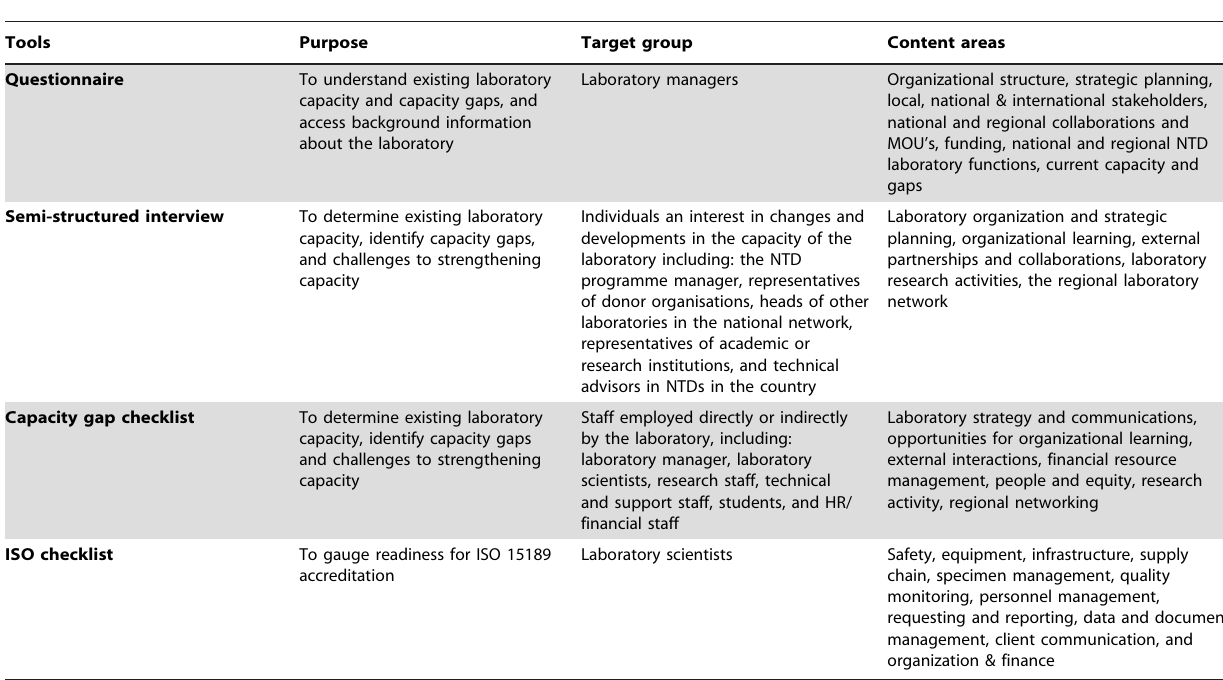
Table 2. Assessment and monitoring